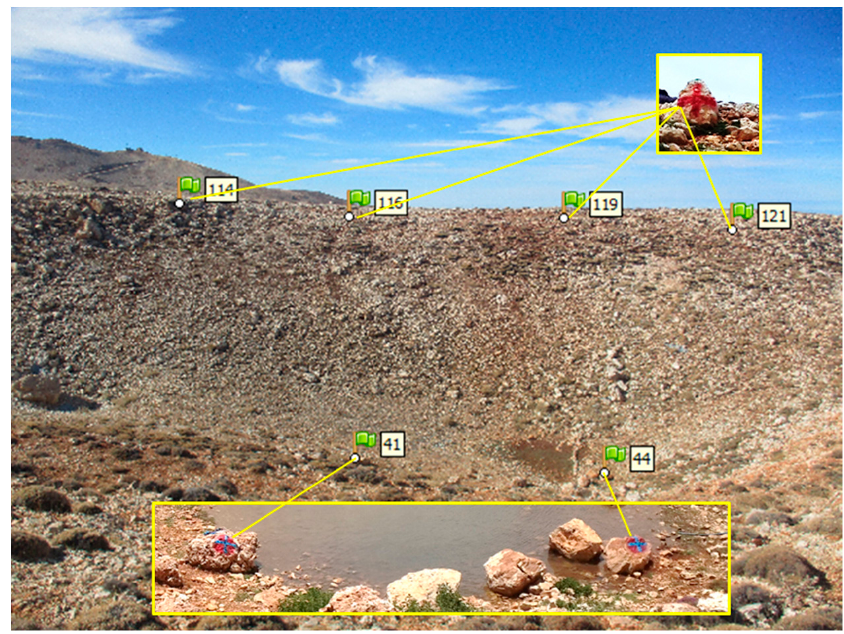
Figure 3. Ground control points (GCPs) distribution in the scene. These GCPs were used to reference the snow-off DEM from the camera photographs and to reference the snow-on digital elevation models (DEMs) in Exp. 1.